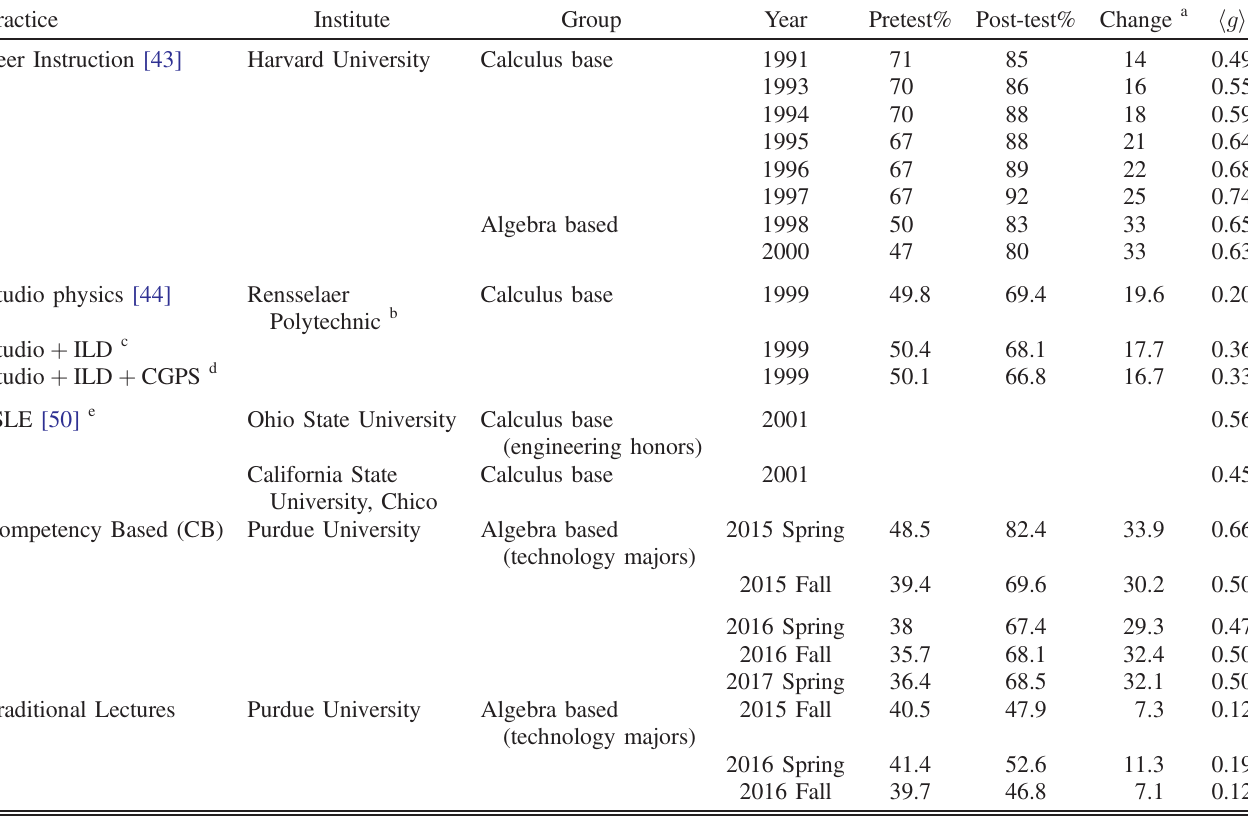
TABLE IV. Summary of FCI measurements for different pedagogical practices. Despite catering to learners showing a lower initial level aptitude (see Pretest %), the h g i of the CB model is comparable to other pedagogical practices performed for advance learners in calculus based streams with higher initial level